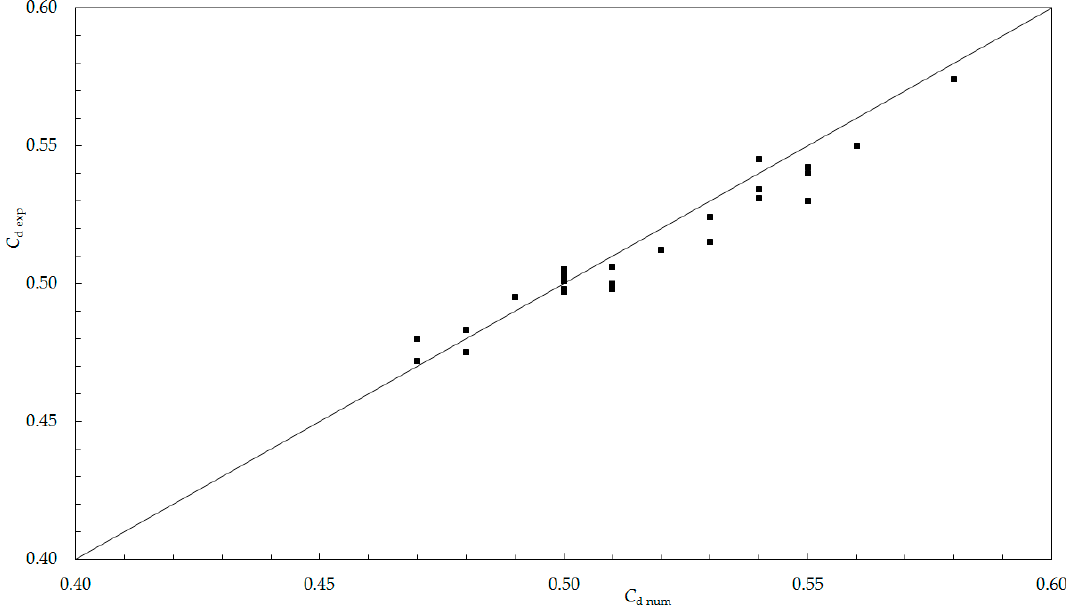
Figure 9. Numerical vs. experimental discharge coefficients of C d , Series 3.